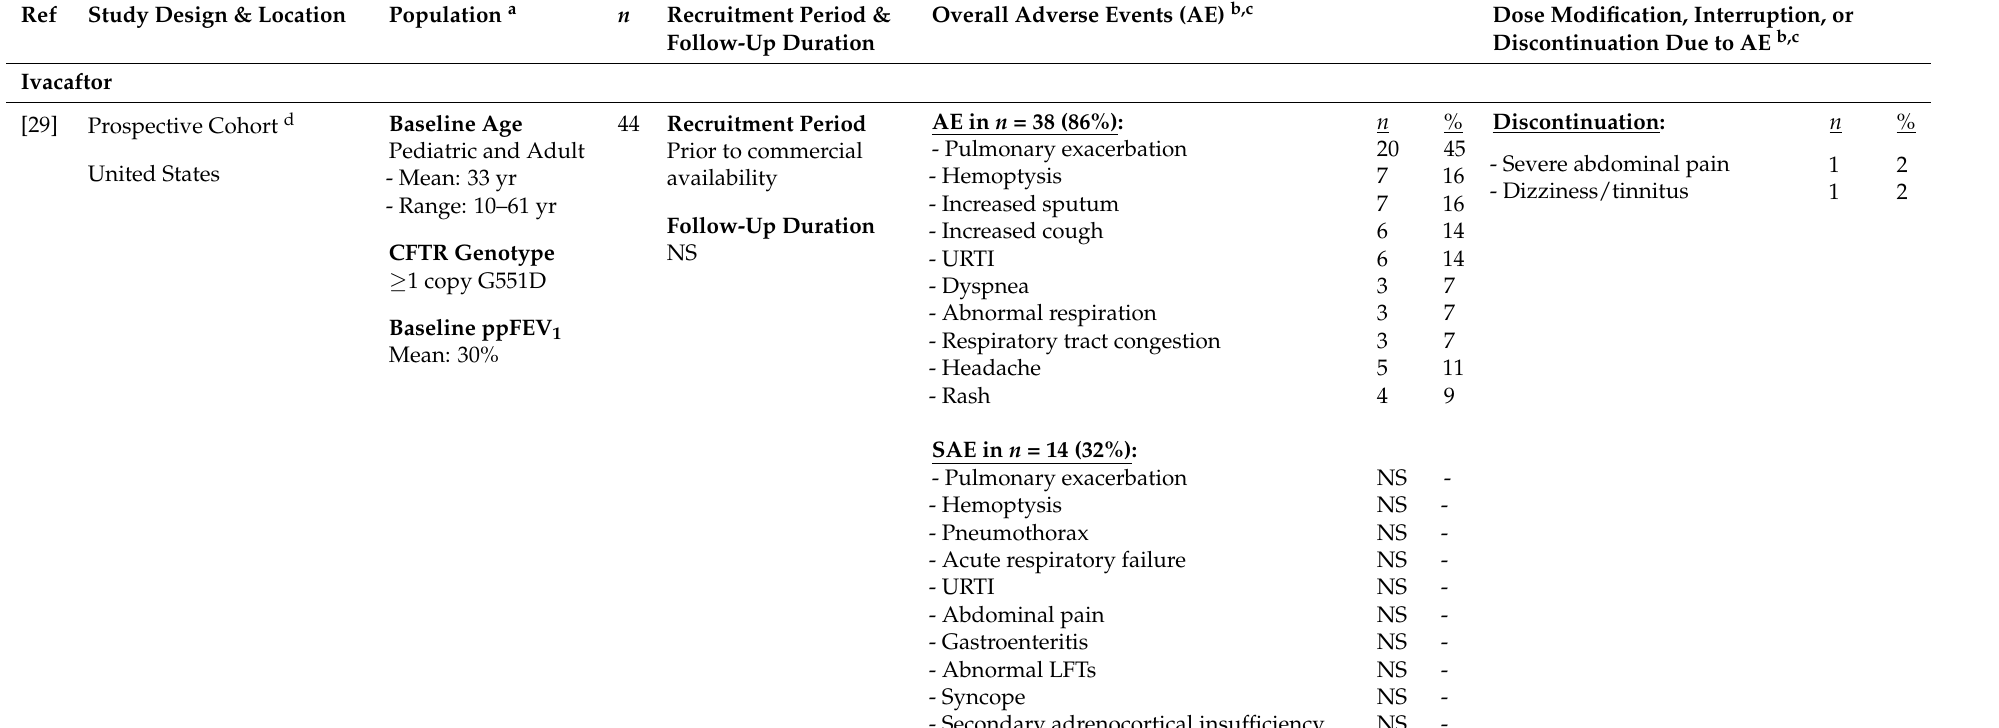
Table 1. Summary of characteristics and results of cohort or survey studies with full